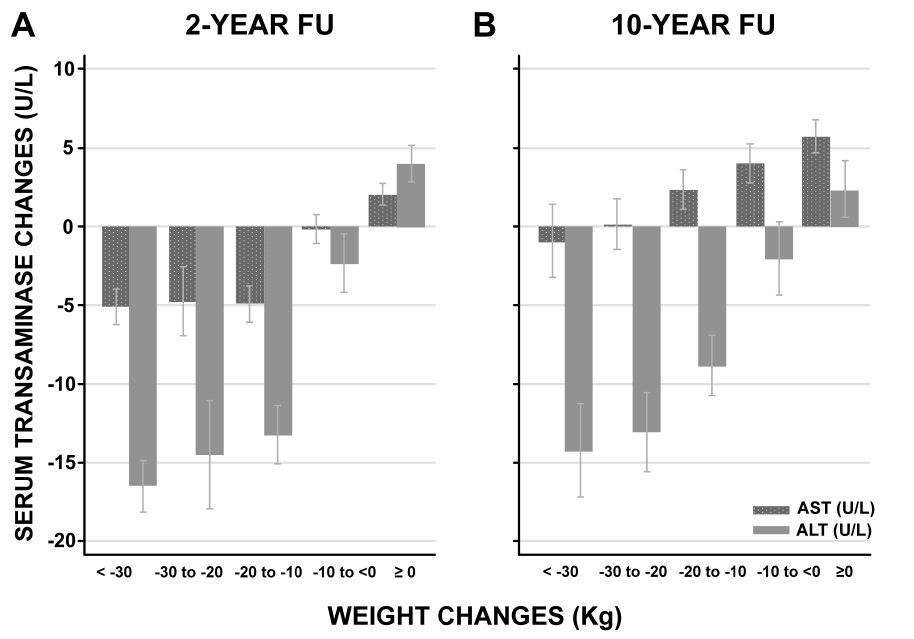
Figure 2. Serum transaminase changes and their relation to body weight changes at 2- and 10-year follow up. The serum transaminase changes are expressed as mean and 95% confidence intervals. The surgery and control groups are pooled. Changes are calculated as the difference between follow up (2 or 10 year) and baseline values. Abbreviations: FU, follow up; AST, aspartate transferase; ALT, alanine transferase.